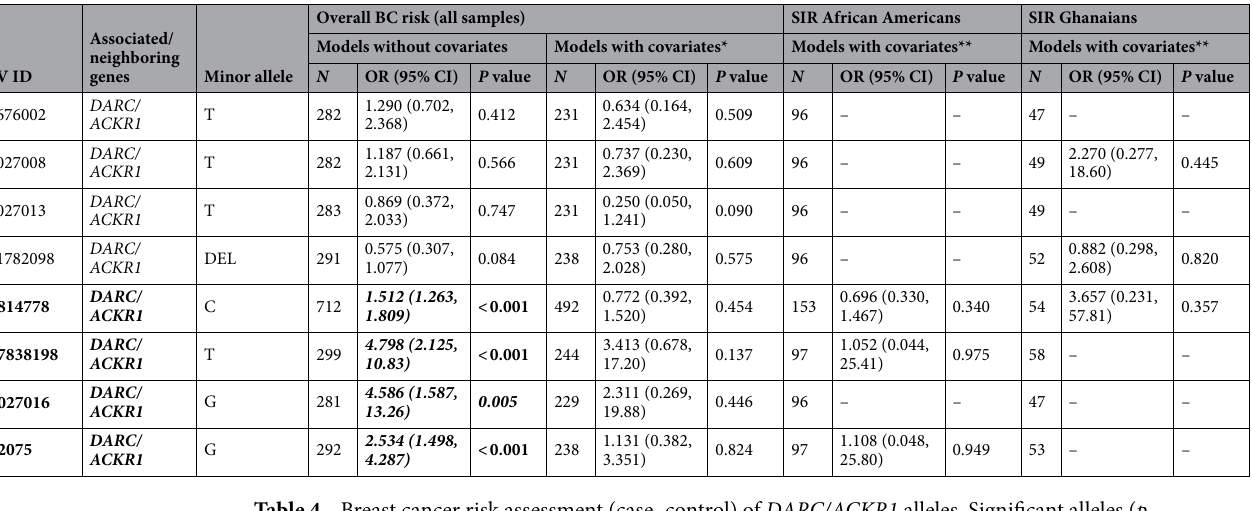
Table 4. Breast cancer risk assessment (case–control) of DARC/ACKR1 alleles. Significant alleles ( p value < 0.05) are given in bold and italic *Overall analysis models with covariates adjusts for age and SIR. **SIR models with covariates adjusts for